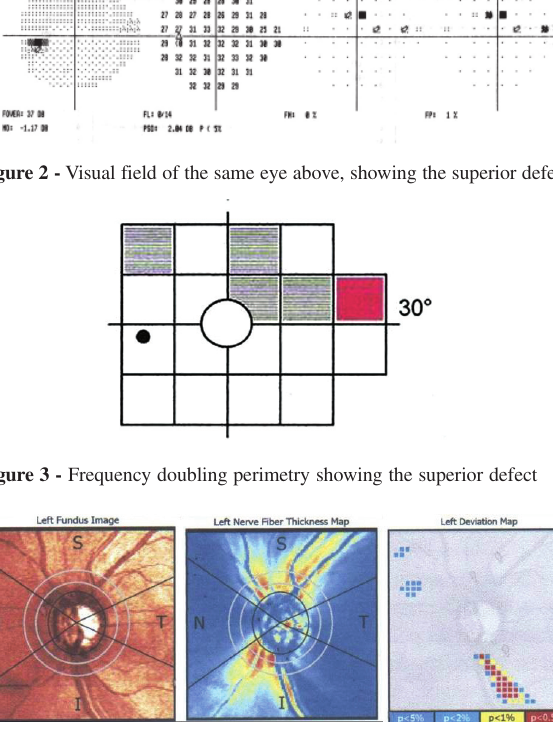
Figure 4 - GDx VCC deviation map with a correspondent localized inferior defect in the nerve fiber